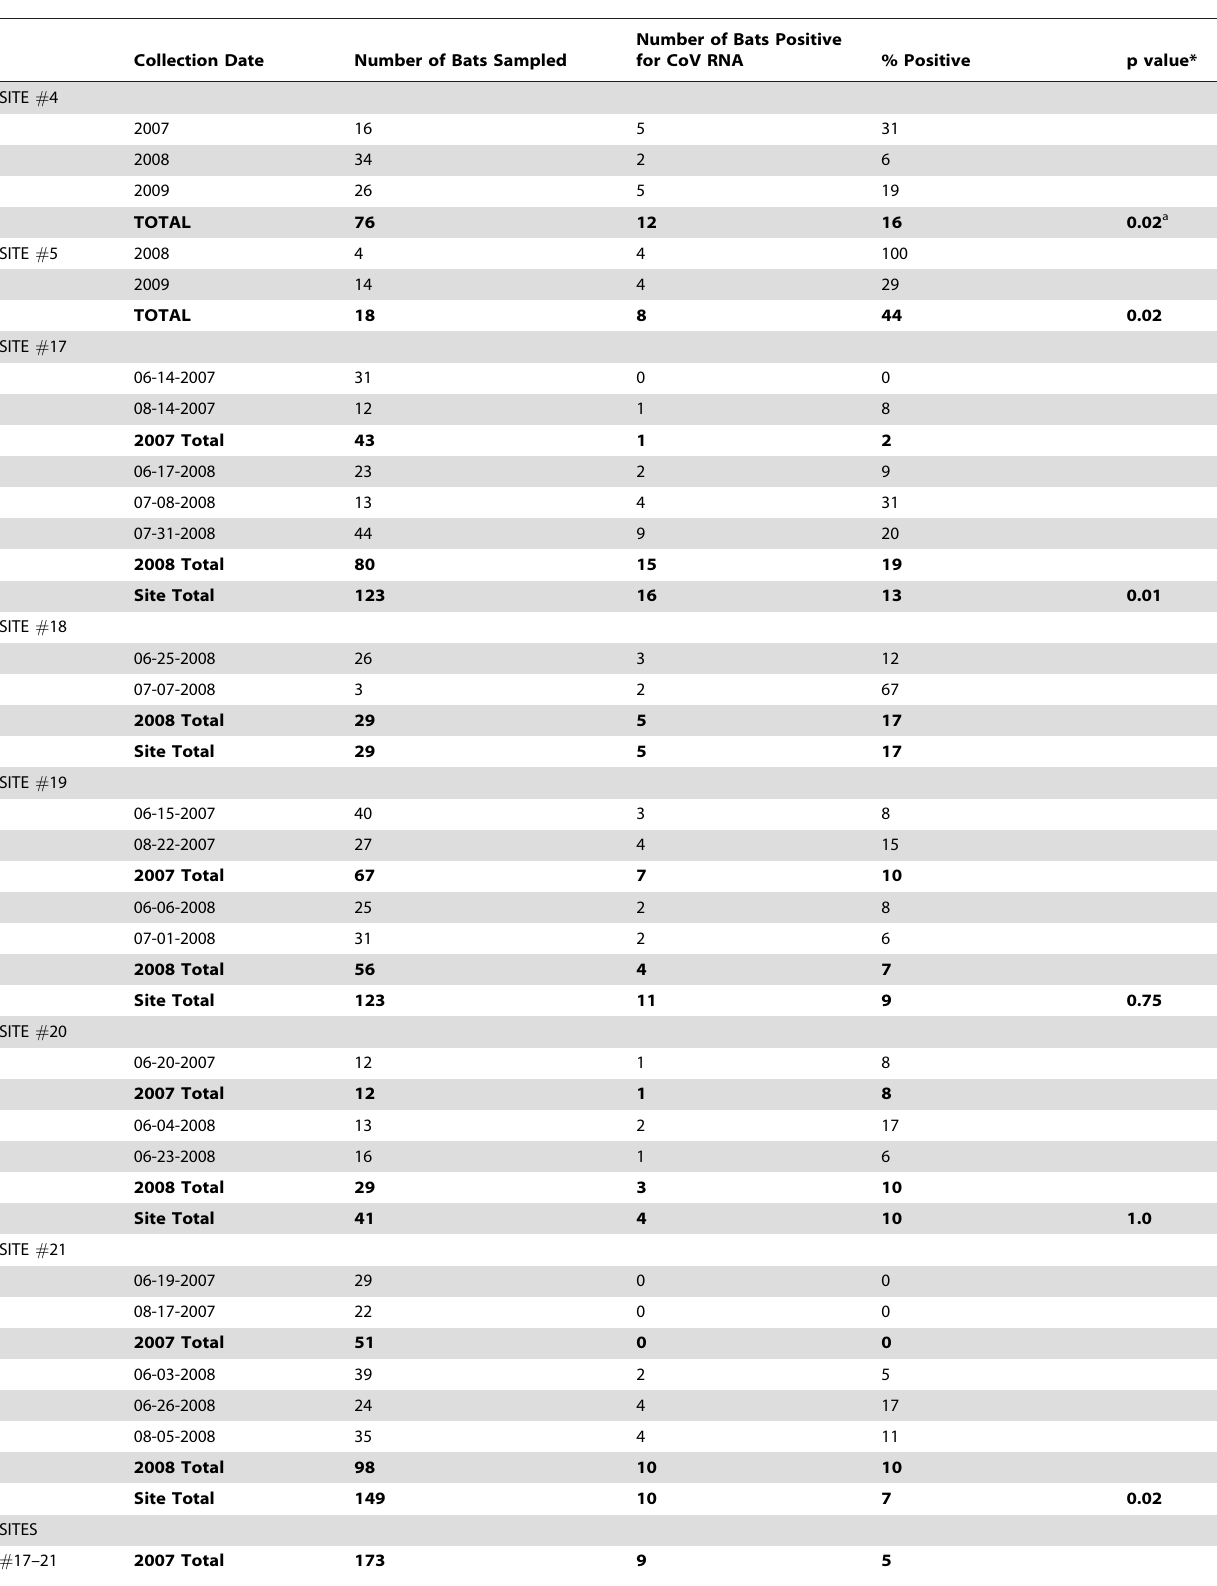
Table 2. Prevalence of coronavirus RNA in long-legged bats (site # 4) or big brown bats (sites # 5, 17–21) in fecal and/or anal swab samples by site of collection and